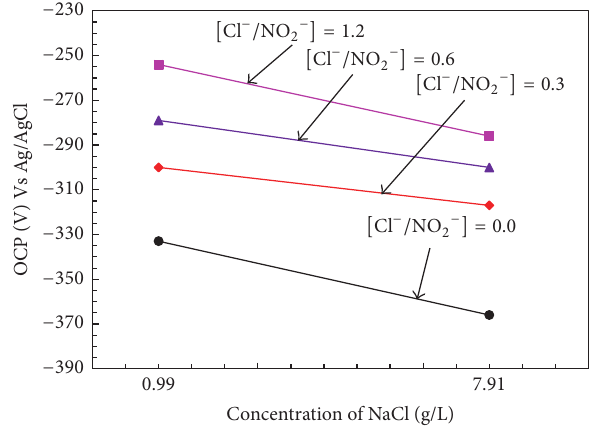
Figure 2: OCP plots of steel rebar exposed in saturated Ca(OH) 2 solution with different concentration of NaCl at different molar ratio of [Cl − /NO 2 −